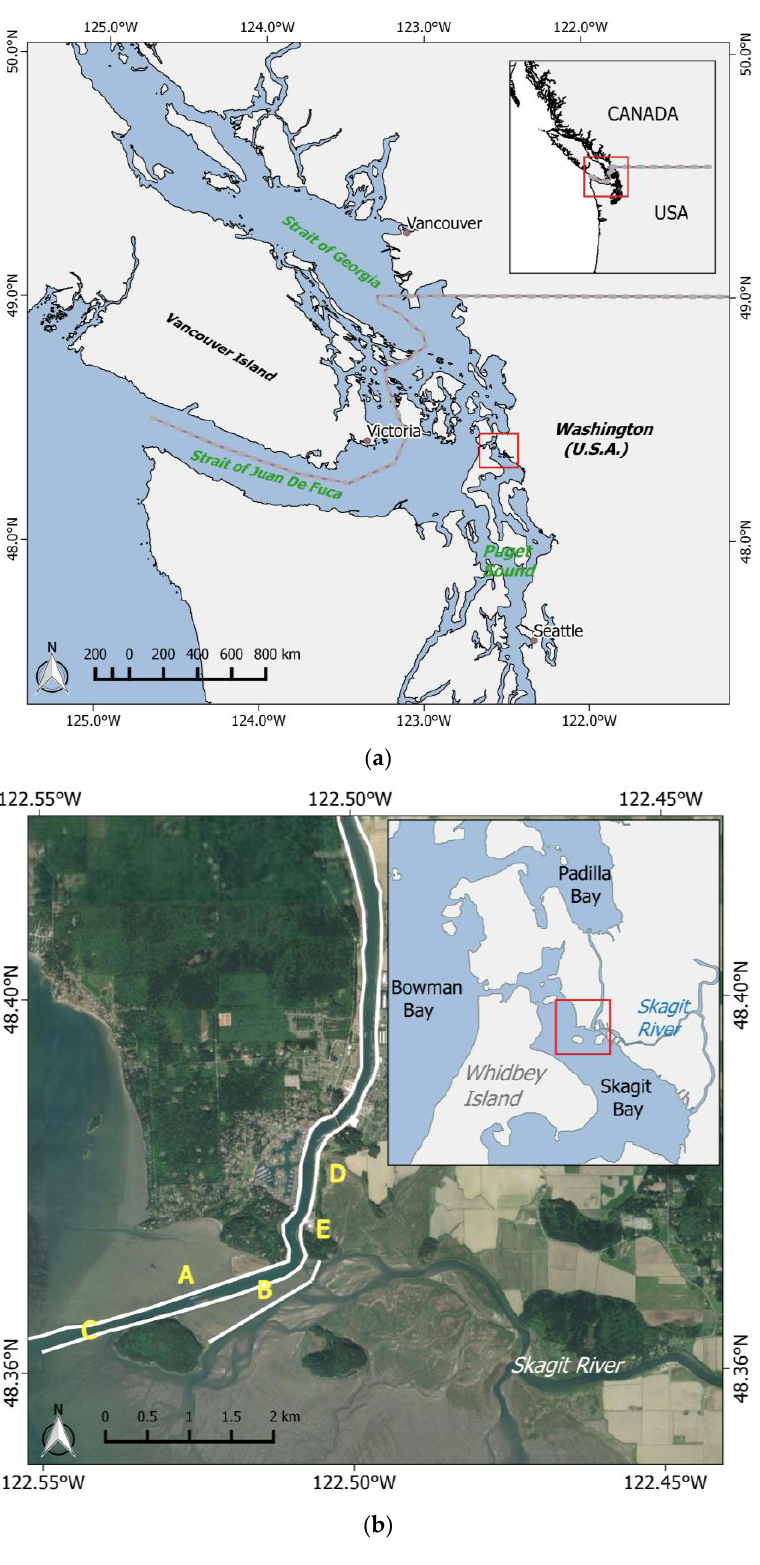
Figure 1. Study area showing, ( a ) Northern Puget Sound area and ( b ) Swinomish Channel near the mouth of Skagit River estuary, located in Whidbey Basin, Puget Sound, Washington. (A) North Dike; (B) McGlinn Island to Goat Island Jetty; (C) South Jetty; (D) McGlinn Island to Mainland causeway, (E) McGlinn Island.